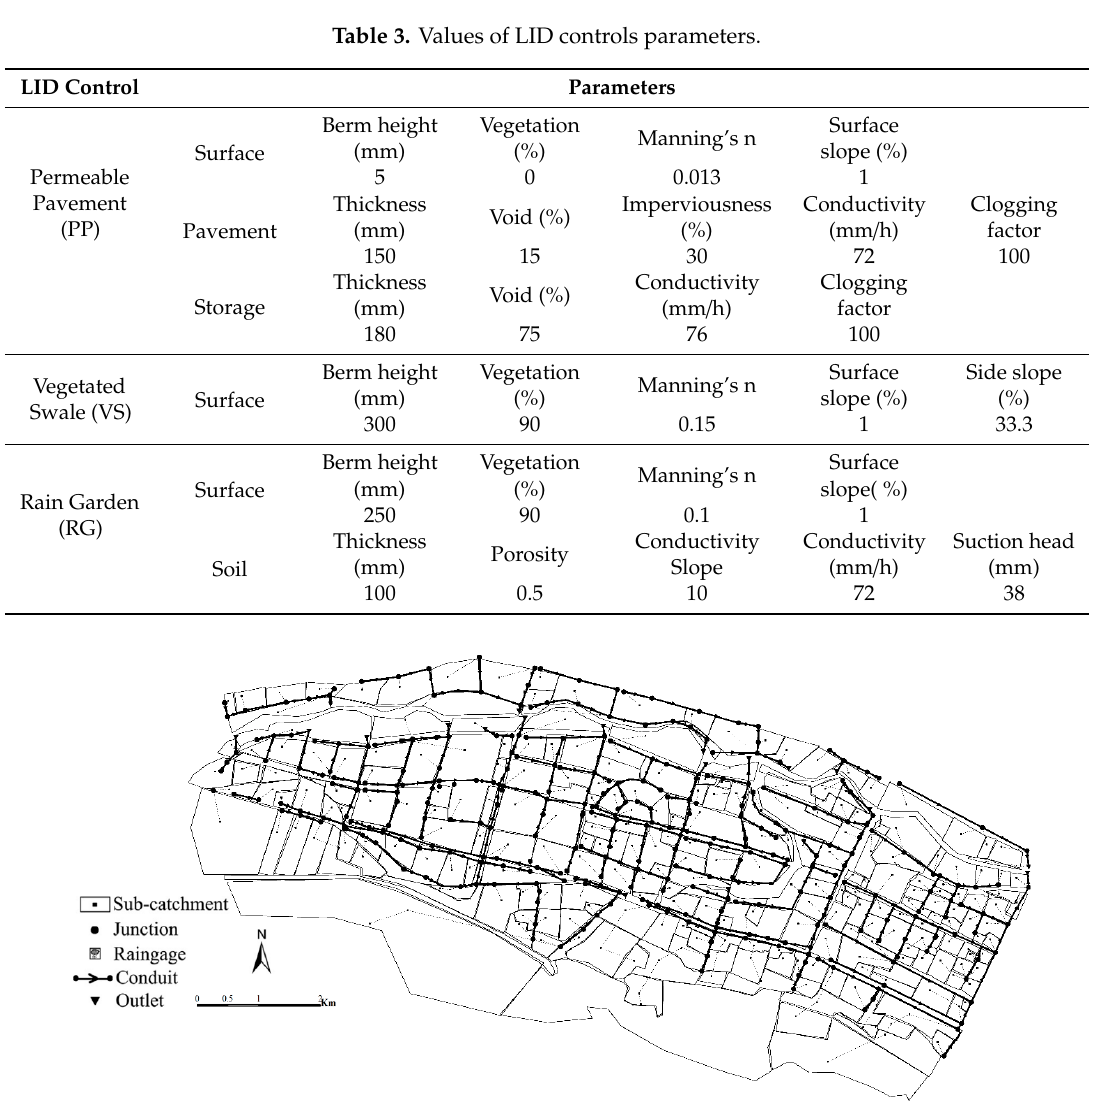
Figure 5. Hydrological model of study area.